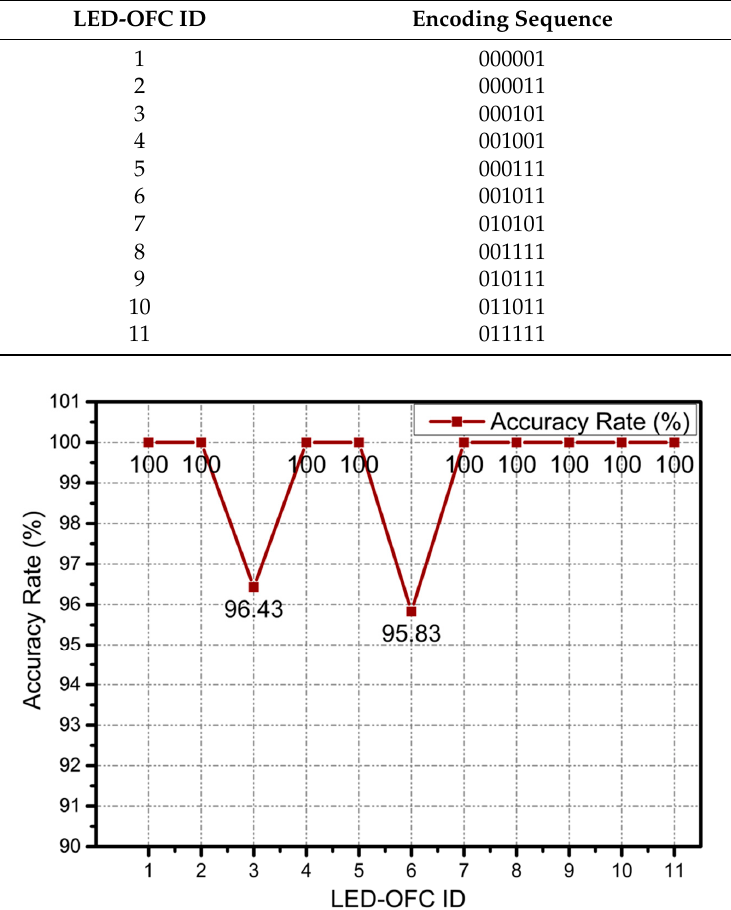
Table 2. Encoding sequences.